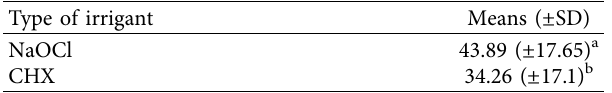
Figure 1: Schematic illustration of the IRR simulation. (a) The crown of each tooth was cross-sectioned at the cementoenamel junction, and (b) the roots were embedded in cylinders (3 cm diameter; 2.5 cm height) of self-cured acrylic resin. Then, (c) IRR was simulated, and (d) finally, the specimens were Table 1: Tukey’s test ( α � 0.05) comparison of readings (means (%) and standard deviation ( ± SD)) for the isolated factor irrigant.